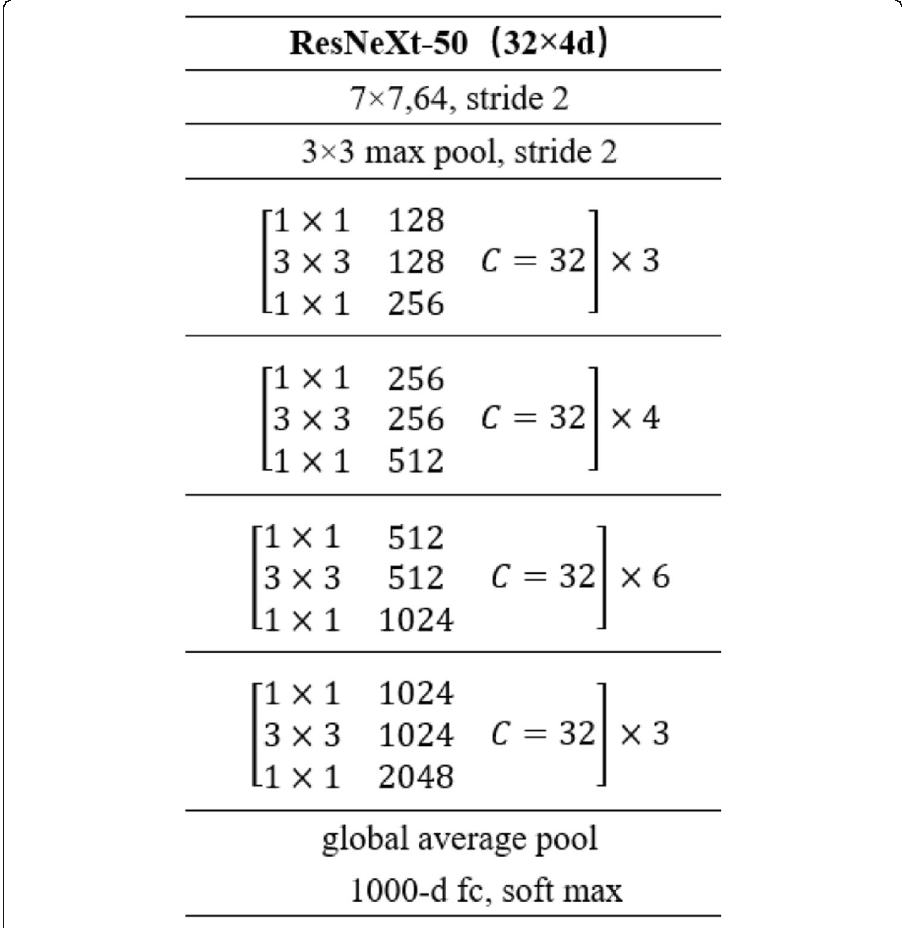
Table 2 Model optimization Included network phase Network depth